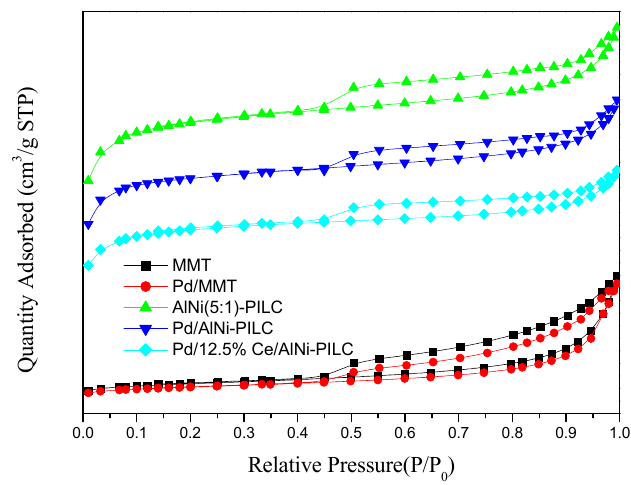
Figure 5. N 2 adsorption/desorption isotherms of the samples. Table 1. Characteristics of the samples: surface area and pore volume.